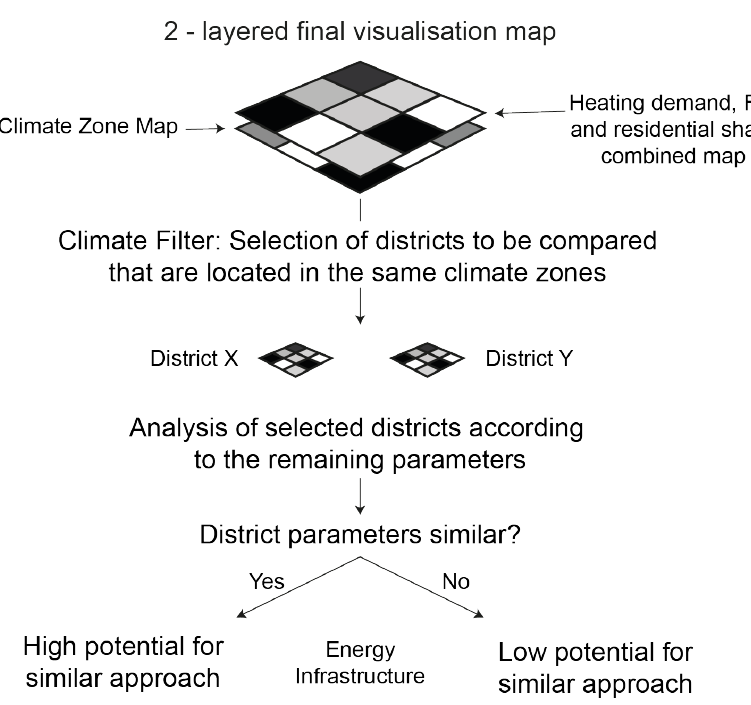
Figure 5. The application process of the final district visualisation